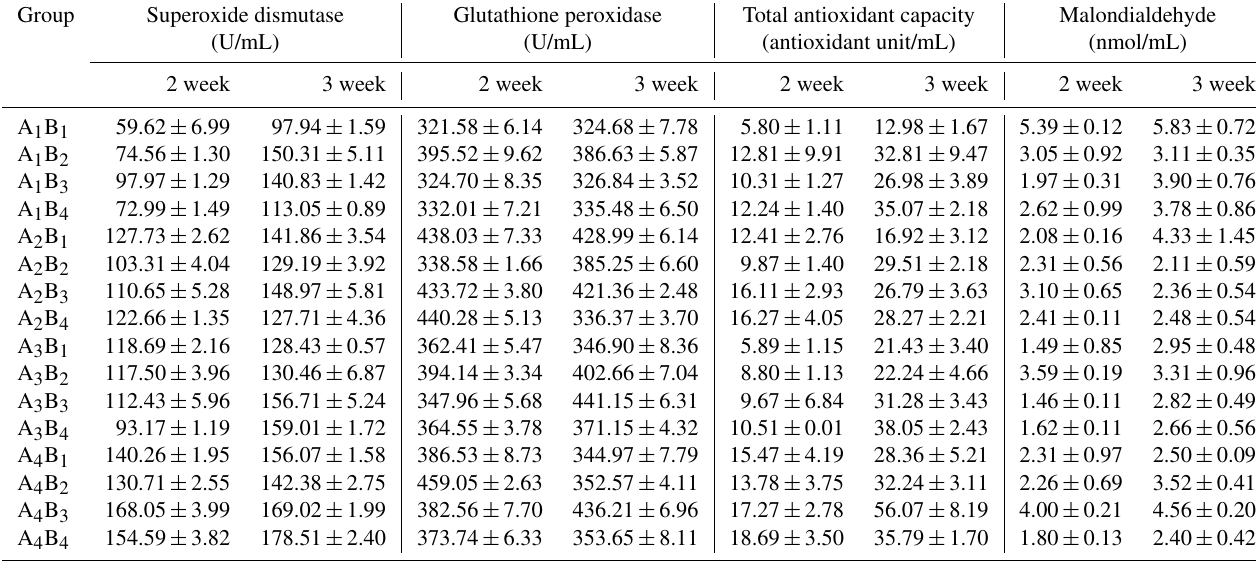
Table 8. The antioxidant capacity of Arbor Acres broilers under low temperature conditions supplemented by glutamine and L-carnitine. Group